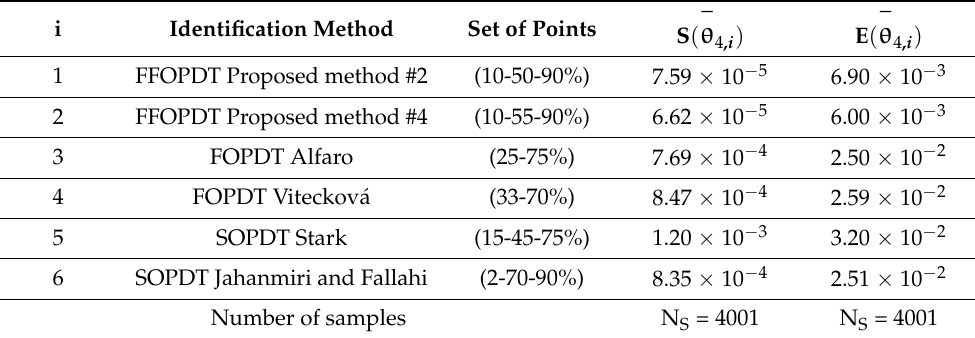
Table 26. Comparison of the approximated models obtained with methods #2 and #4 and models for FOPDT and SOPDT in terms of time-domain model performance indices for the thermal-based process at a certain operating point. The number of samples N S is also displayed.